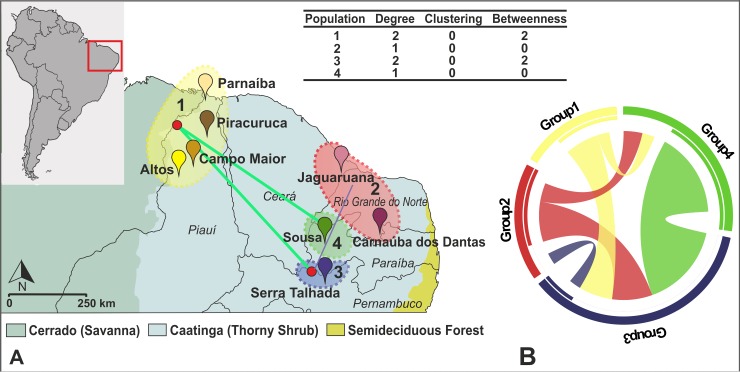
A—Populational network based on microsatellite data showing two populations (1 and 3) as source of migrants for all others, based on higher values of degree and betweenness components. Red circles represent the fundamental units of the system (i.e. source-sink populations). Each line represents the connection of a source population to a sink population. Line thickness is proportional to linkage strength of such relationships. B—Migration pattern of R. nasutus in the Caatinga region based on Migrate-n analysis. The color of each stripe in the middle of the circle represents the color of the source group of migrants. The width of each stripe is proportional to the number of migrants.